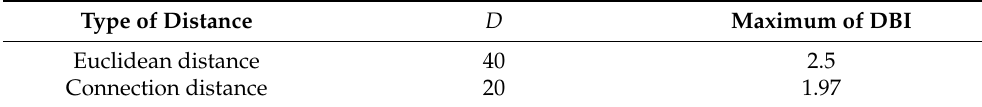
Table 2. Optimal parameters of D in DBI.